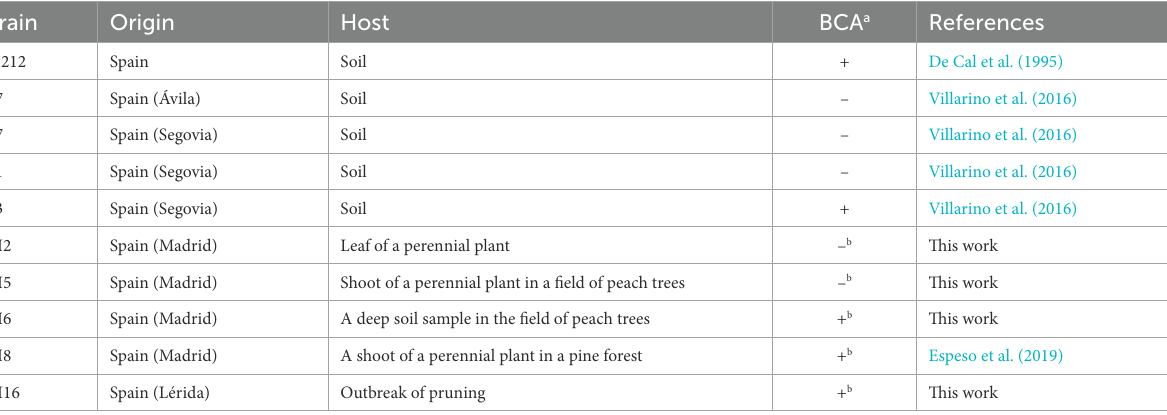
TABLE 1 List of Penicillium rubens strains used in this